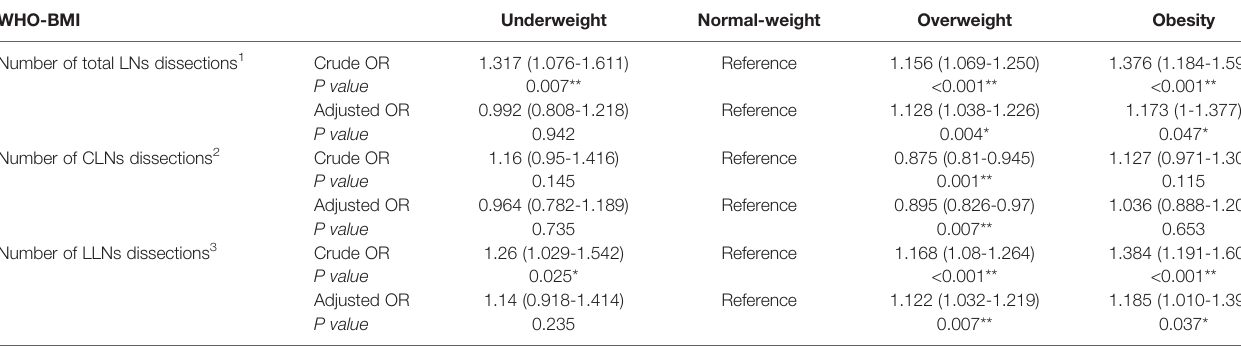
TABLE 6 | Binary logistic regression analyzed the relationship between BMI and the number of LNs dissections.